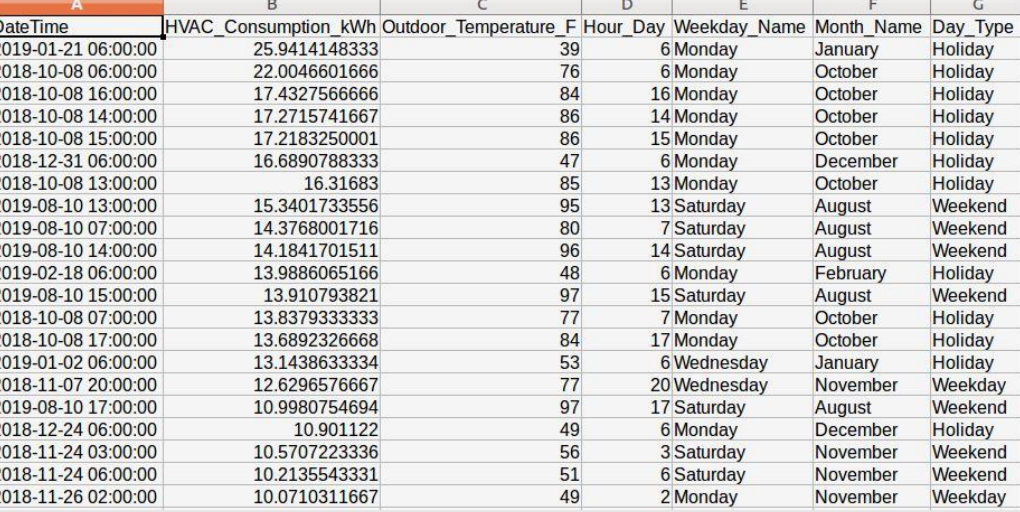
Figure 15. A sample of timeslots with high HVAC consumption—cluster2.